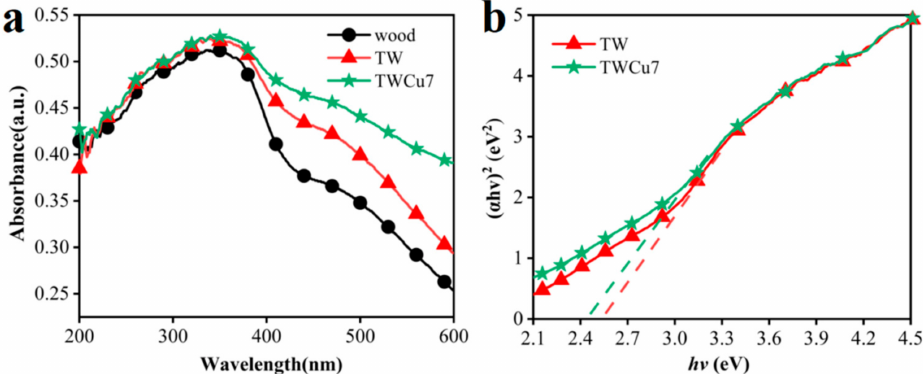
Figure 4. UV-Vis diffuse reflectance ( a ) spectra and ( b ) bandgap energies of wood, TWm and TWCu7